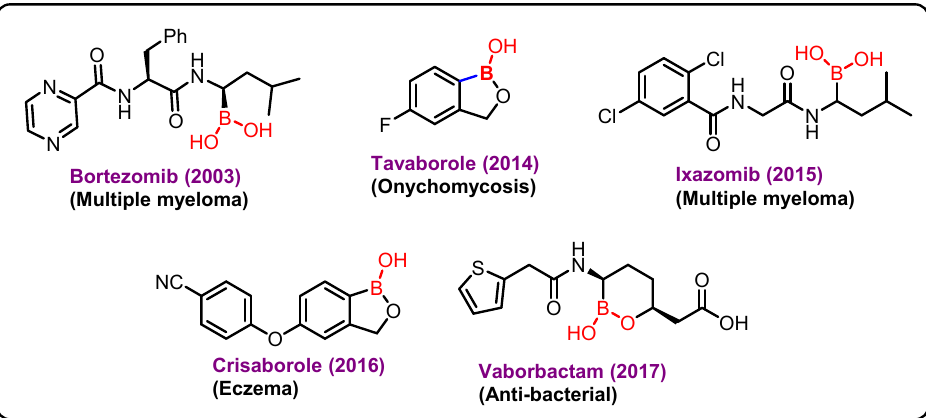
Figure 6. Boron-based marketed